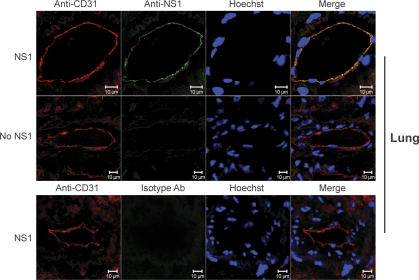
Binding of DENV NS1 to Human LungCryo-sections of human lung tissue were incubated with 20 μg/ml of purified DENV-2 NS1 or BSA for 1 h at room temperature. Bound NS1 was detected by staining with a mixture of DENV NS1 mAbs (1A4, 1F11, 2G6, 1B2) followed by Alexa Fluor 488 conjugated with goat anti-mouse IgG. Subsequently, the sections were co-stained with rabbit anti-human CD31 (PECAM-1) followed by Cy3-conjugated donkey anti-rabbit IgG. Nuclei were stained with a DNA-specific dye (Hoechst) and the sections were analyzed by confocal microscopy. Sections incubated with purified DENV NS1 and stained with isotype mAbs served as a negative control.